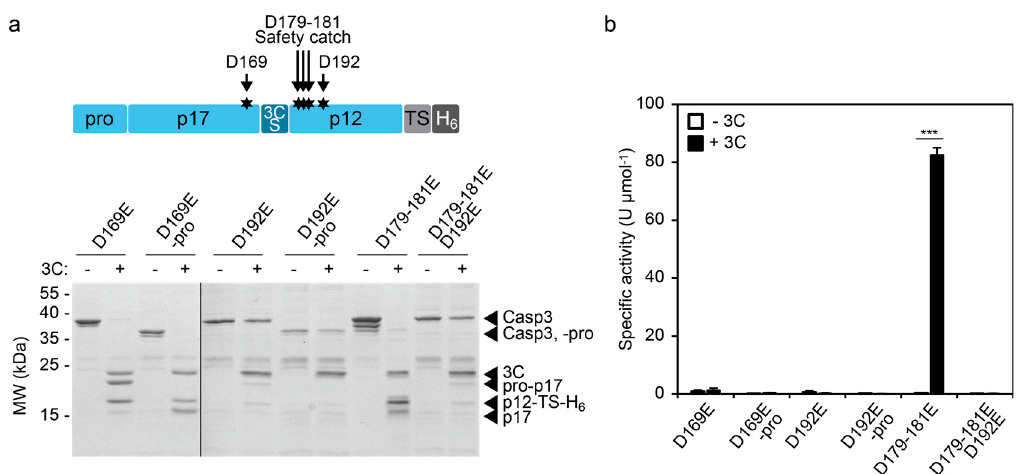
Figure 4. E ff ects of aspartate mutations on cleavage and activity of the inducible CASP3 (3CS_ins). ( a ) 3C protease-mediated cleavage of aspartate-to-glutamate CASP3 (3CS_ins) mutants. The indicated CASP3 constructs (5.2 µ M or 5.7 µ M of the constructs with or without prodomain, respectively) were incubated in the absence ( − ) and presence ( + , 2.4 µ M) of 3C protease (3C) for 4 h at RT and evaluated using SDS-PAGE. ( b ) Activity of mutant CASP3 (3CS_ins) constructs. The indicated CASP3 mutants were incubated with ( + 3C) or without ( − 3C) 3C protease as described in (a). Specific activities were assessed using a colorimetric assay using 1:100-diluted samples and a synthetic peptide substrate. Mean values of three replicates +/ − s.e.m. are shown. Statistics: unpaired t-test; *** p < 0.005. CASP3 (3CS_ins)-D169E was e ffi ciently cleaved by 3C protease (Figure 4a). However, the